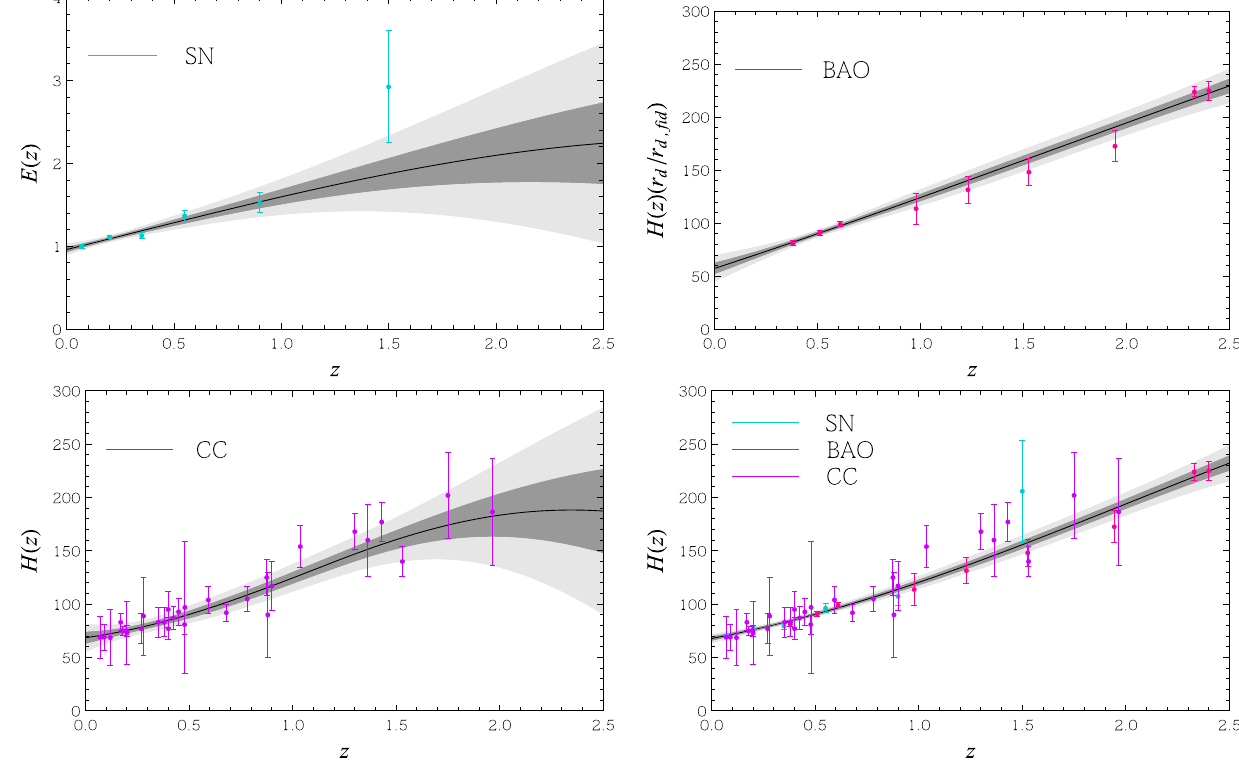
Fig. 1 H ( z ) (in units of km s − 1 Mpc − 1 ) vs z ( E ( z ) vs z in case of SN data alone) with 1 σ and 2 σ CL regions, reconstructed from SN (top-left), BAO (top-right), CC (bottom-left) and SN+BAO+CC data